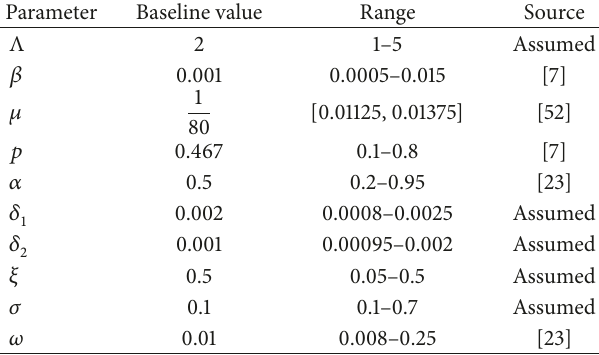
Table 2: Parameter baseline values and ranges used in sensitivity analysis.